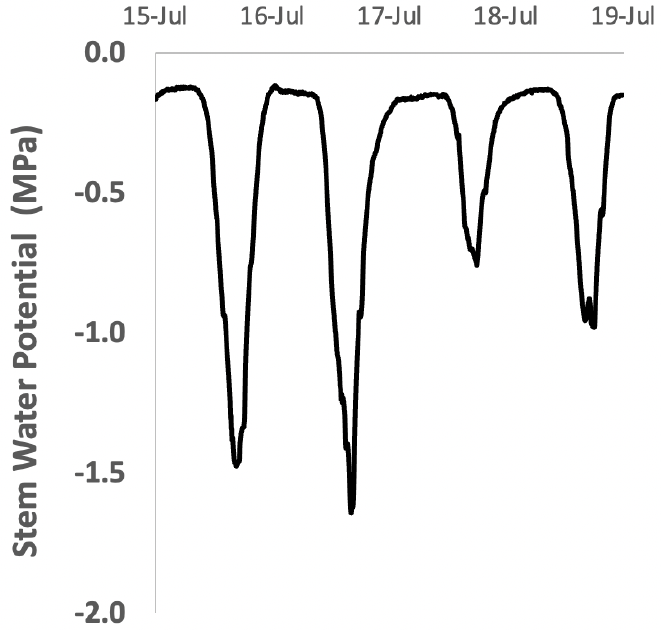
Figure 4. A typical diurnal pattern of stem water potential in an ‘ Empire ’ /M9 apple tree in New York with mild-moderate soil moisture deficit in July. The first two days were sunny and warm, the third day overcast and the fourth day partly cloudy.